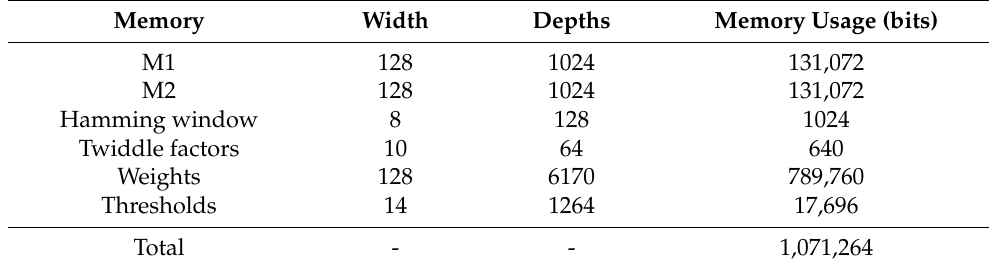
Table 5. Memory usage of the proposed HGR system.